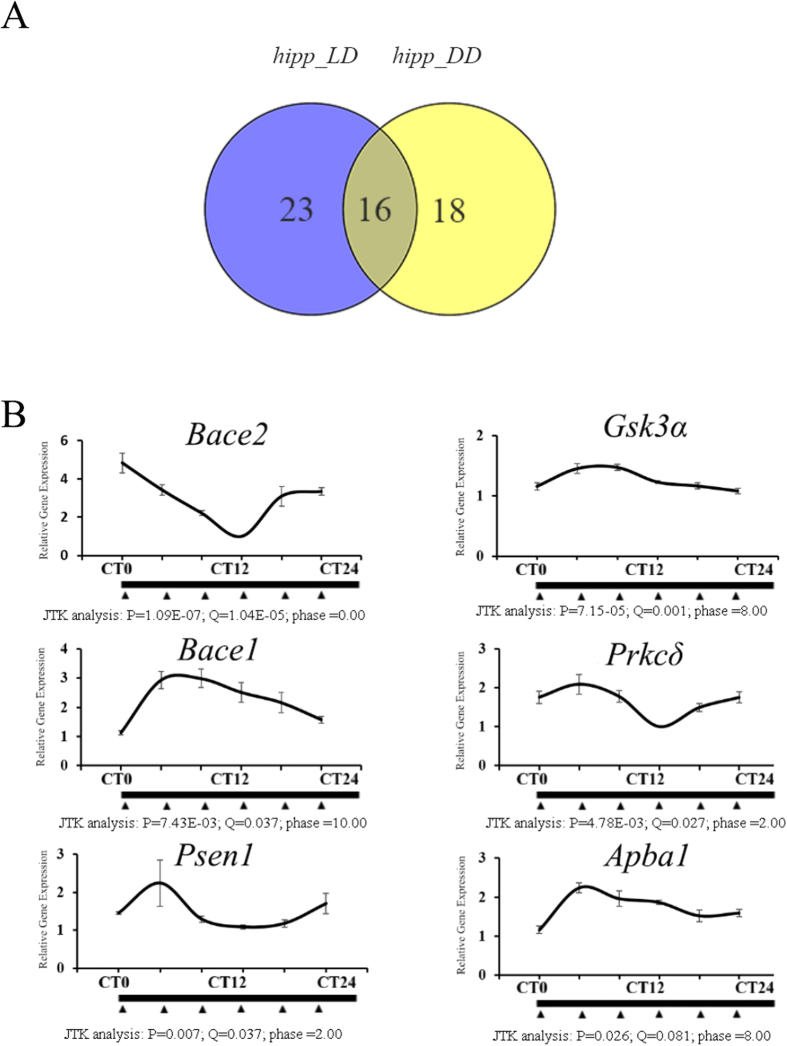
qPCR results and Venn diagram of commonly rhythmic expressed genes in hippocampus under different light conditions.(A) Genes that are predicted by the JTK_CYCLE algorithm to be potentially rhythmically expressed under both the LD condition and the DD condition in the hippocampus. (B) The expression patterns of Bace1, Bace2, Psen1, Prkcδ, Gsk3α, and Apba1 in the hippocampus in the LD condition; the cycling parameters predicted by the JTK_CYCLE algorithm are listed under the graph of the relative expression of each gene. The qPCR primers used for the expression analysis of the target genes are detailed in Supplementary Tables 1 and 3.